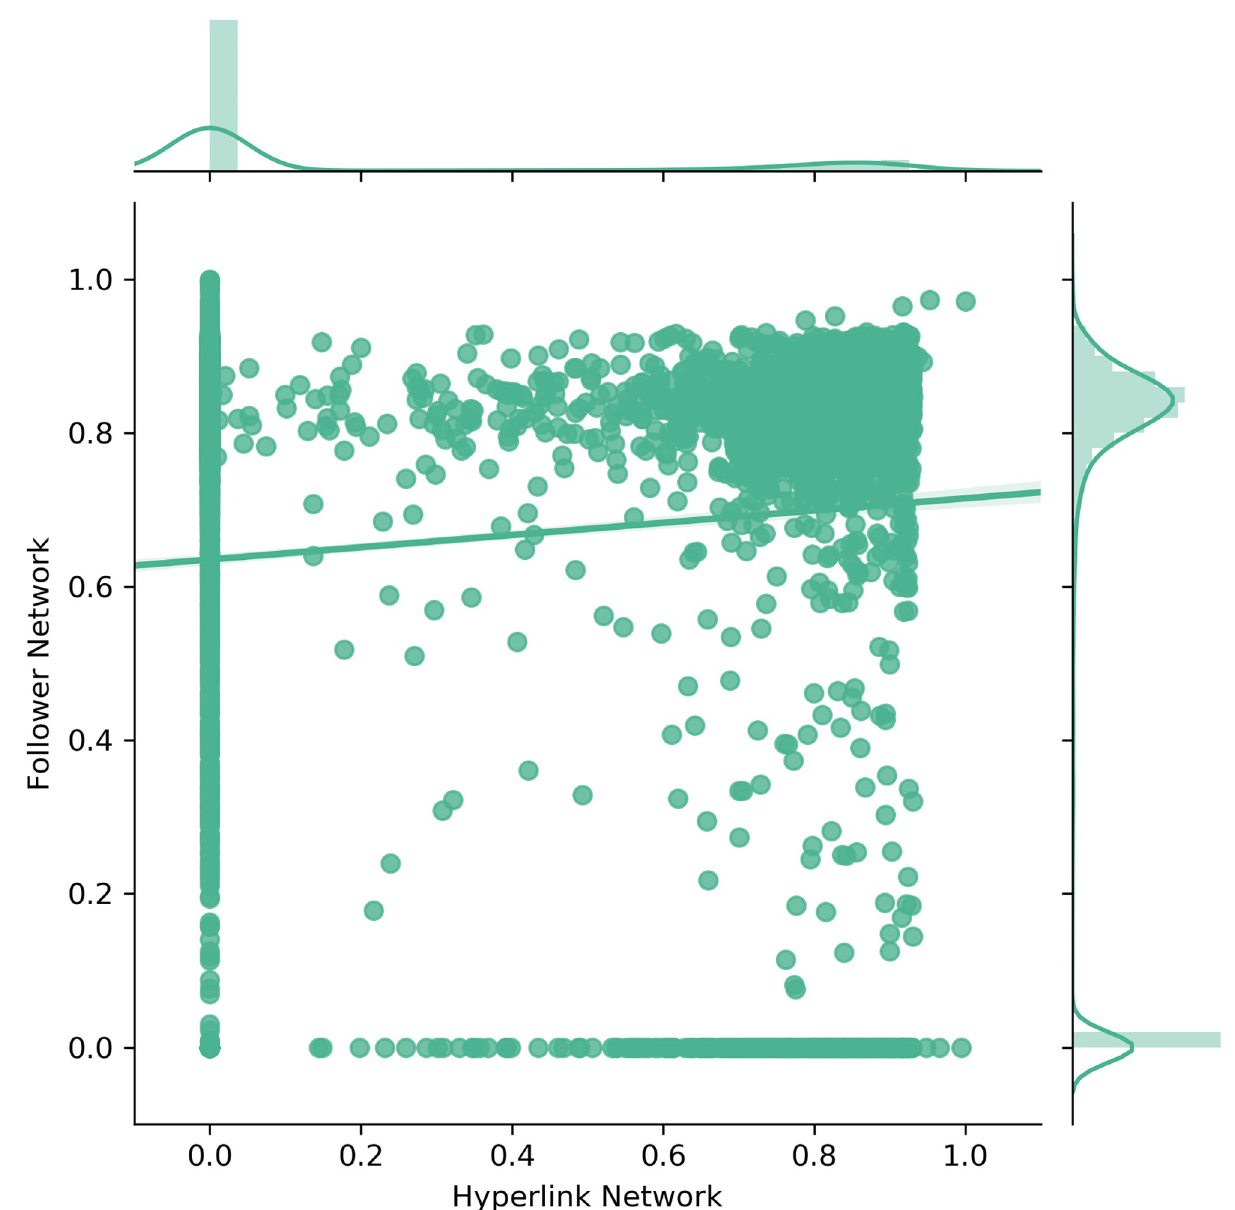
Fig 7. Scatter and density plots for geographic